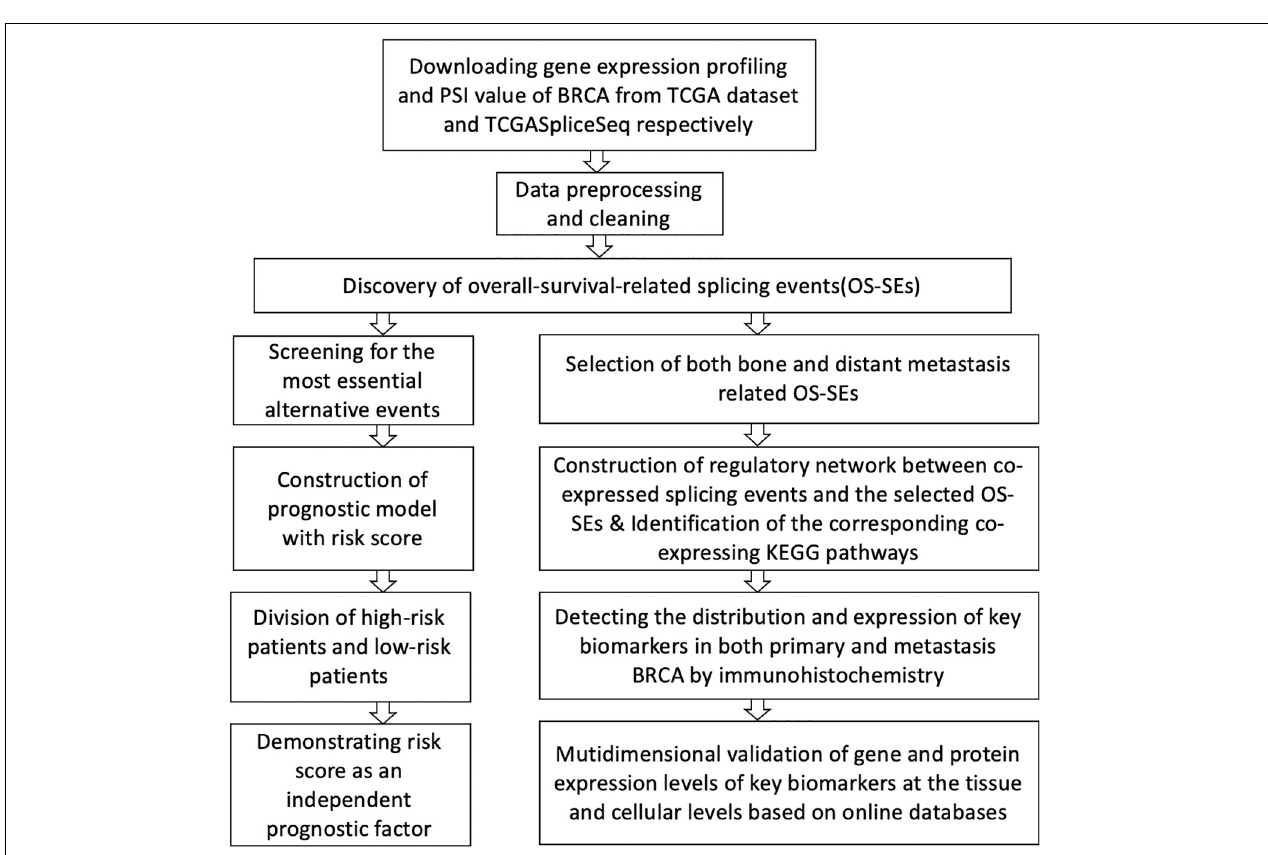
FIGURE 1 | Schematic overview of the whole